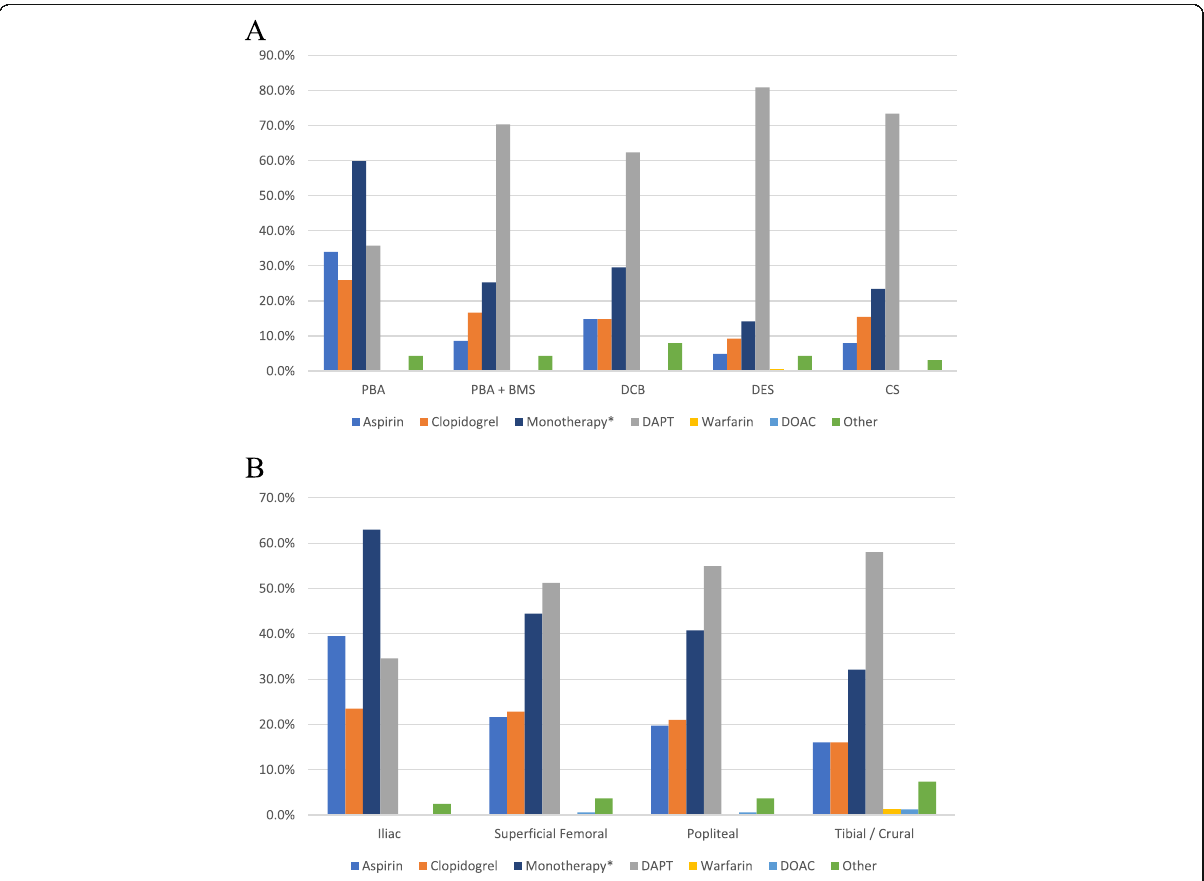
Fig. 3 Antithrombotic therapy stratified by procedure ( a ) and anatomical location ( b ). Legend: DAPT dual antiplatelet therapy. DOAC direct oral anticoagulant. PBA Plain balloon angioplasty. BMS Bare metal stent. DCB Drug coated balloon. DES Drug eluting stent. CS Covered stent. *Monotherapy = composite of aspirin, clopidogrel and ‘ other regime ’ where an antiplatelet agent was